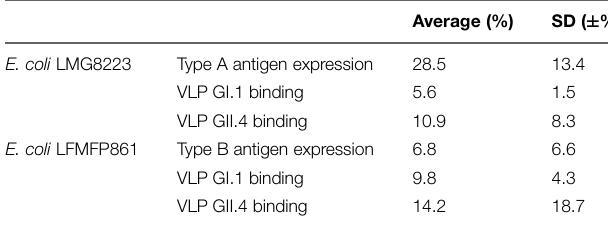
TABLE 3 | The HBGA expression and binding of human NoV VLPs to the bacteria E. coli LMG8223 and E. coli LFMFP861 (percentage of positively stained cells determined by flow cytometry analysis, three independent